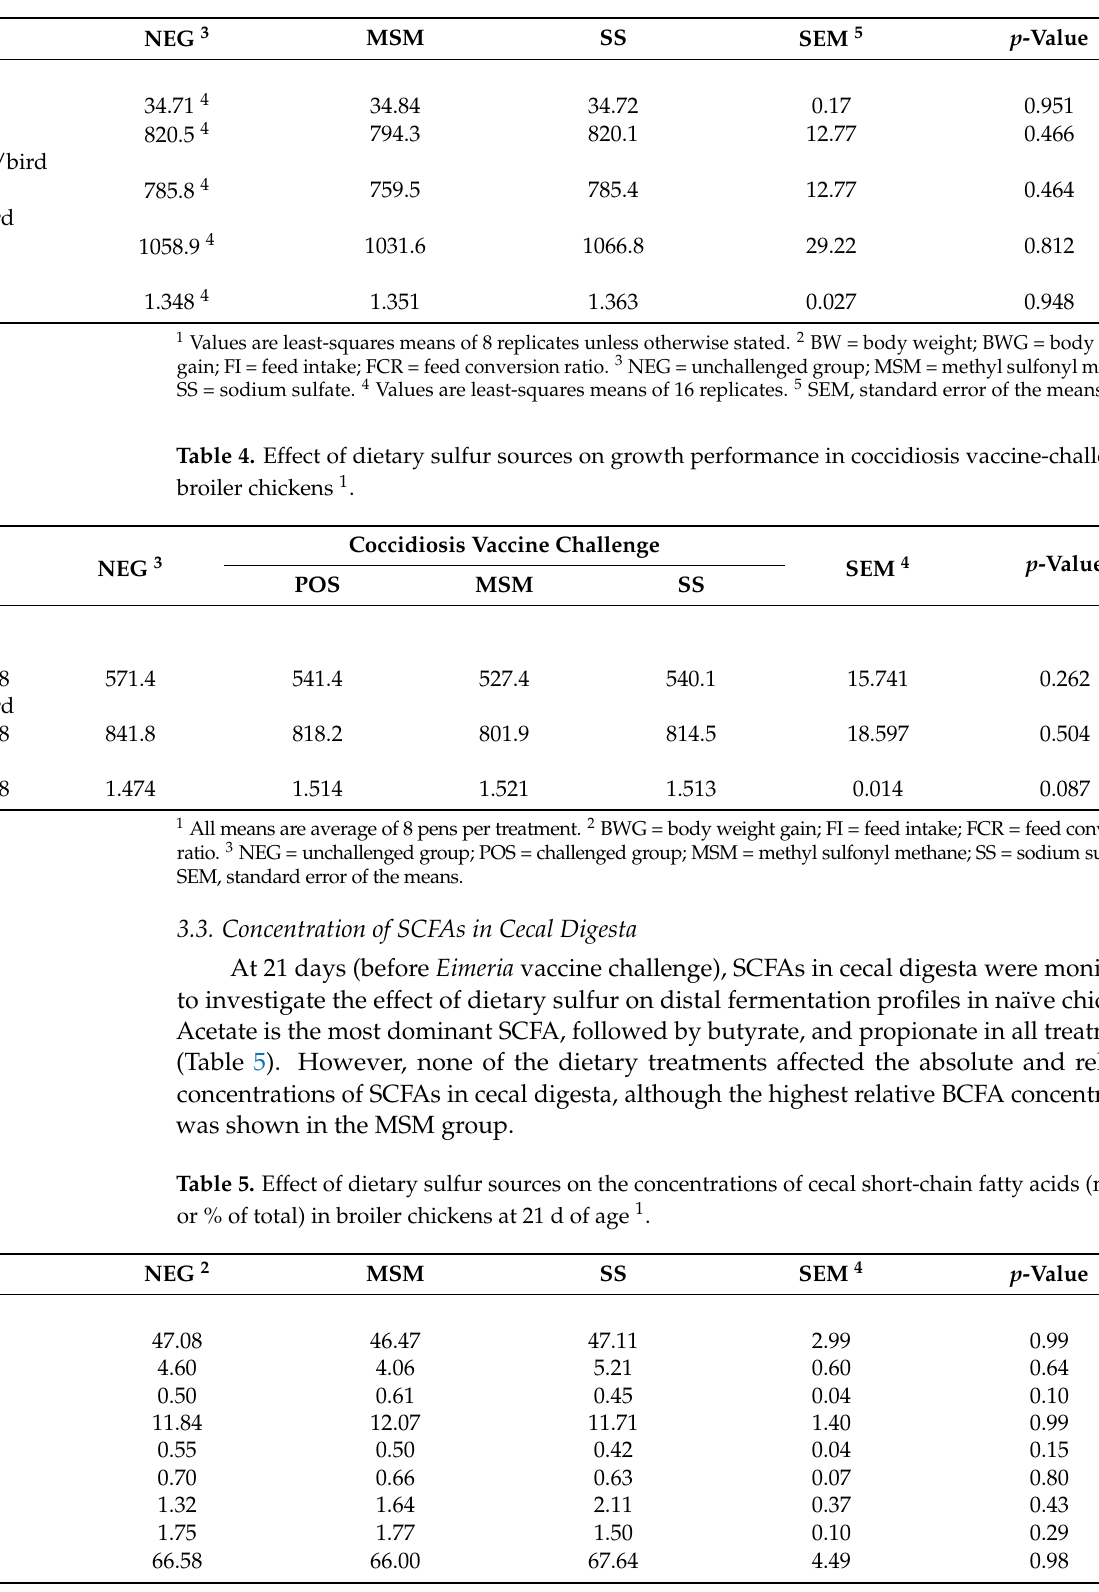
Table 3. Effect of dietary sulfur sources on growth performance in broiler chickens 1 .